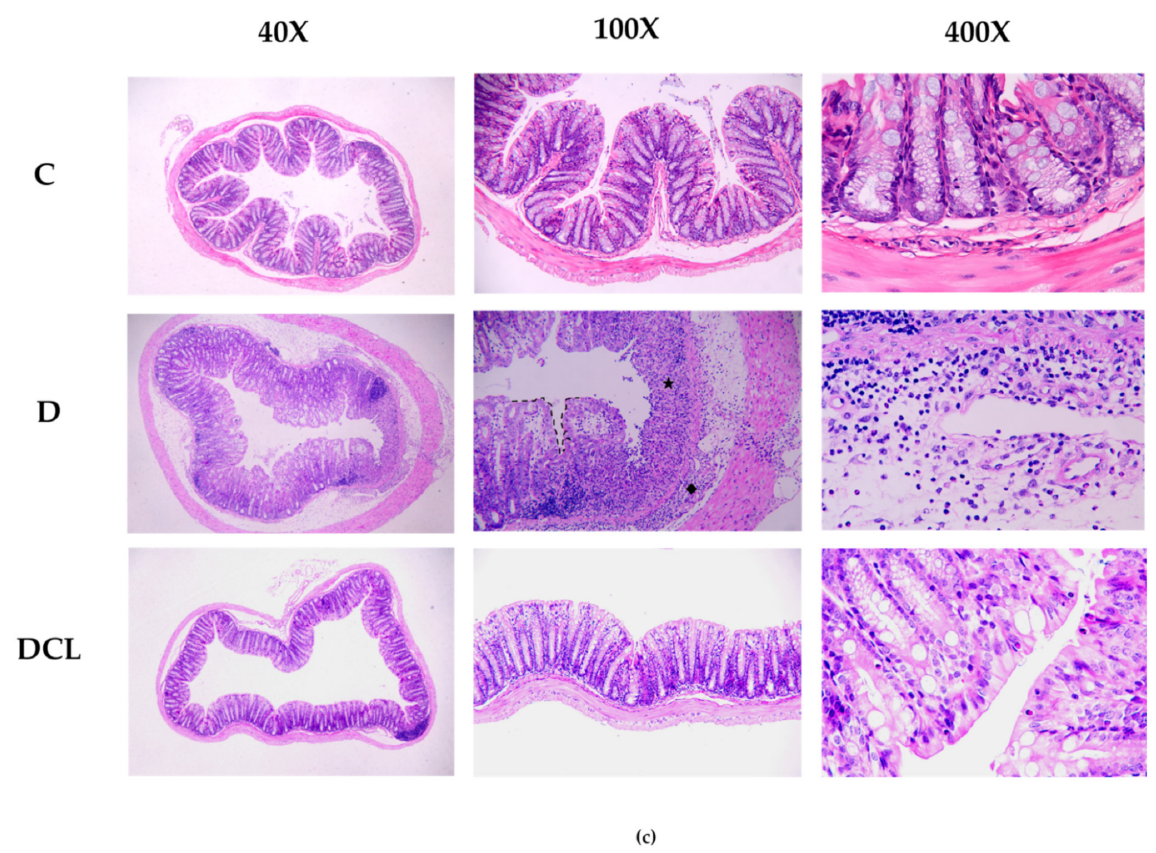
Figure 2. Colonic inflammation in DSS-induced colitis (Control, C; DSS-treated mice, D; DSS-C3G (12.5 mg/kg), DCL; DSS-C3G (25 mg/kg), DCM; DSS-C3G (50 mg/kg), DCH). ( a ) Determination of colon length. n = 7~8. ( b ) Colon histopathological changes of mice in DSS-induced colitis. n = 7~8. ( c ) Representative pathological pictures of H&E staining. (cid:70) : Destruction of gland structure;